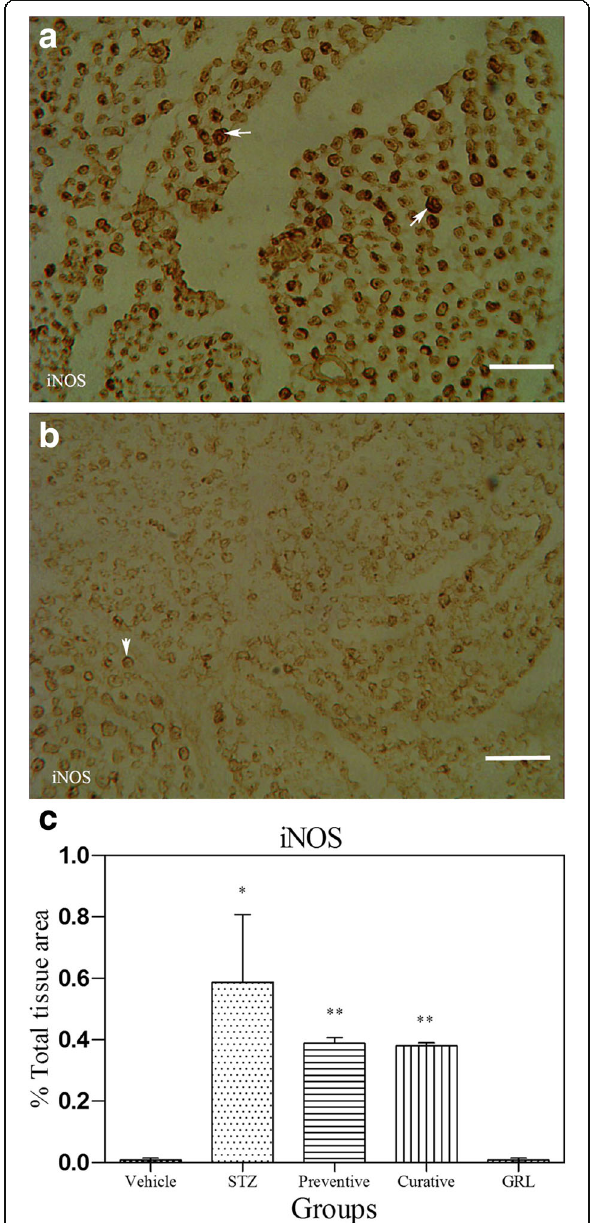
Fig. 6 Light Photomicrographs show immunohistochemical expression of iNOS in STZ ( a ) and STZ plus GRL ( b ) groups (original magnification: ×400, bar: 250 μ m). The positive staining of iNOS is presented by a brown color of cytoplasm (arrows). Densitometry analysis of immunohistochemical photomicrographs for iNOS was assessed. Data are expressed as a percentage of total tissue area ( c ) of 7 rats/group.